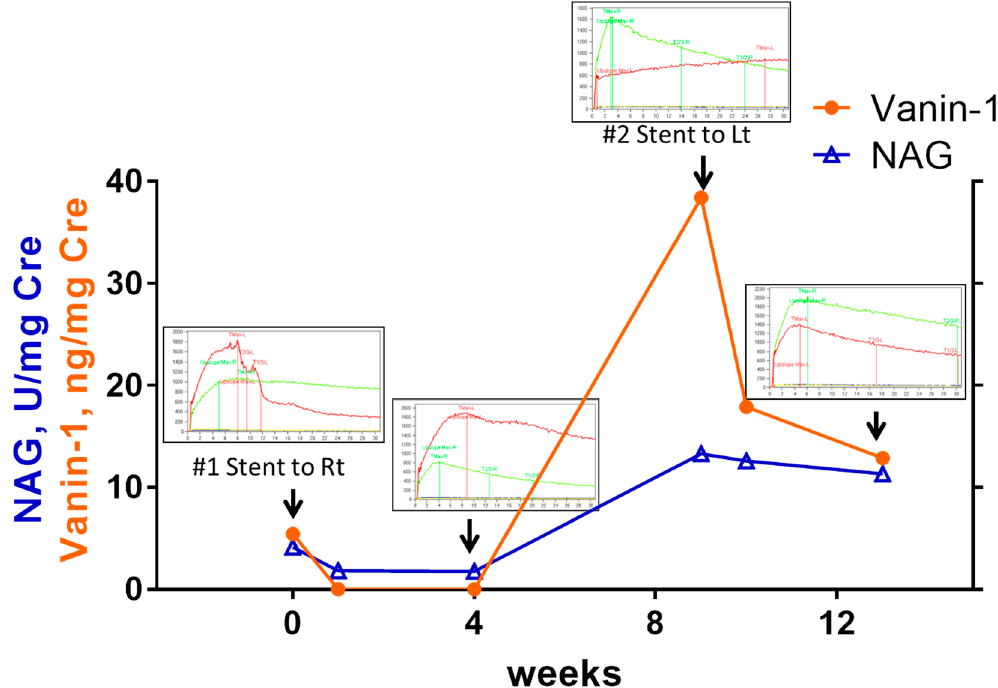
Figure 6. Changes in vanin-1 and NAG in a patient with asynchronous bilateral hydronephroses. Changes in vanin-1 (orange line and circles) and NAG (blue line and triangles) in a patient with asynchronous bilateral hydronephrosis are shown. Changes in MAG3 renal scan results are also shown. In each case, a ureteral double J stent was placed in the affected kidney.